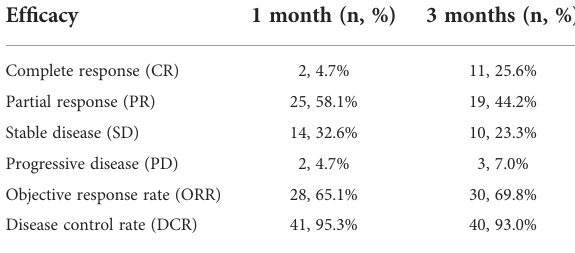
TABLE 2 Short-term treatment effects of local